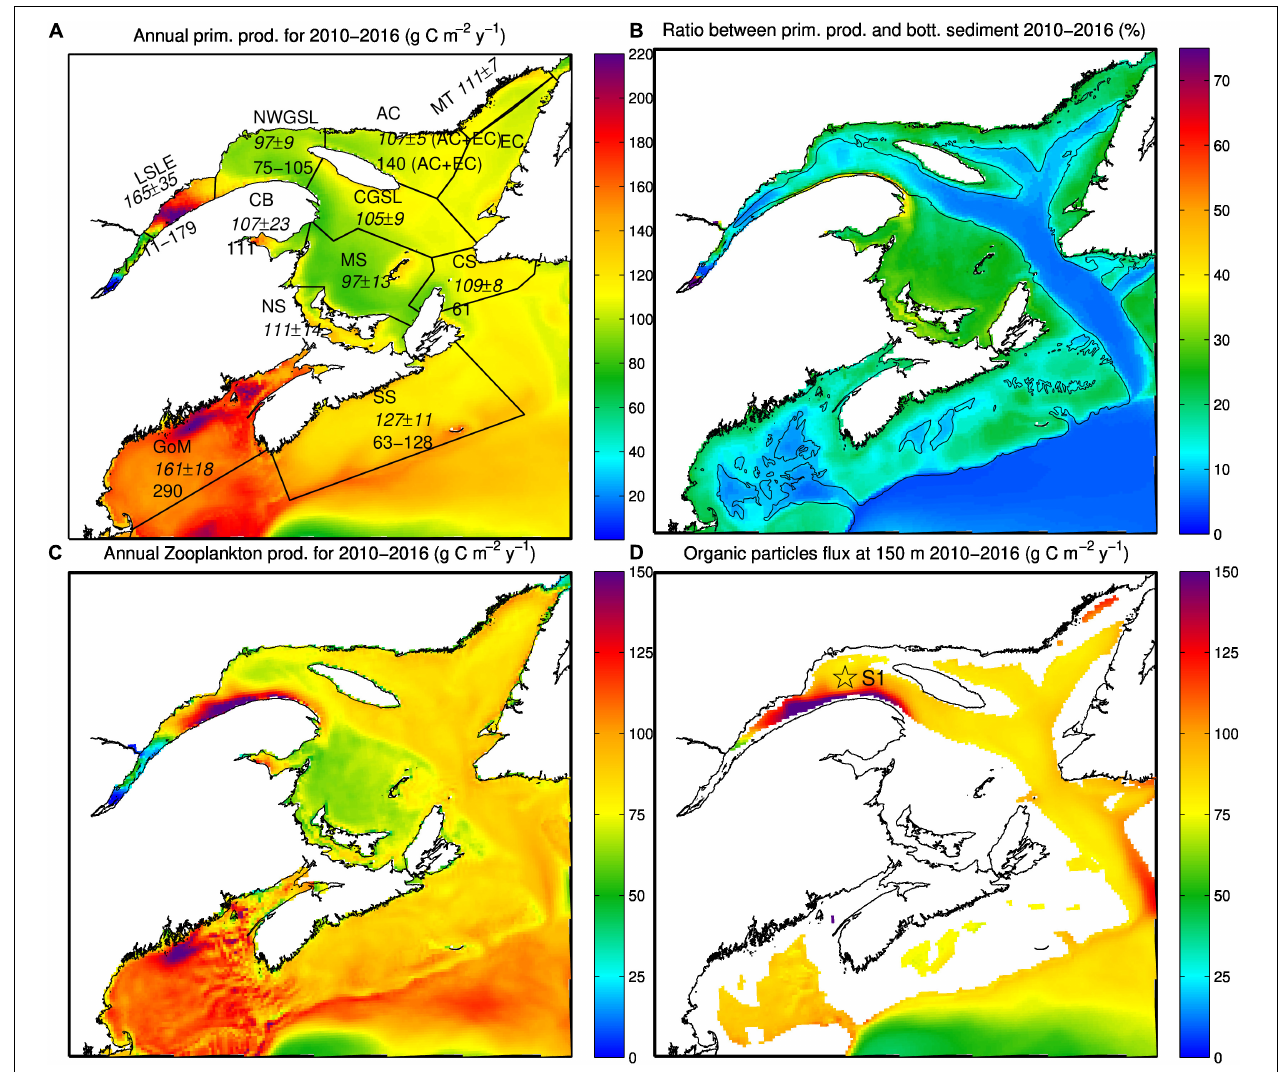
FIGURE 9 | Averages, over the 2010-2016 period, of (A) primary production (background color, g C m − 2 y − 1 ), (B) percentage of primary production that reaches the sediments, (C) zooplankton production (g C m − 2 y − 1 ), and (D) particulate organic matter flux across the 150-m horizon. The average primary production calculated by the model as well as its standard deviation is displayed in italic in panel (A) for different regions (LSLE, NWGSL, AC, EC, CGSL, CB, MS, CS, SS, and GoM). The range of estimates from the literature is also displayed below the simulated average when available. The estimates are taken from Sinclair et al. (1976); Levasseur et al. (1984), and Therriault and Levasseur (1985) in LSLE, Sévigny et al. (1979) and Savenkoff et al. (1996) in the NWGSL, in Savenkoff et al. (1996) for AC+EC and CS, in Legendre (1971) for CB, in O’Reilly and Busch (1984) for the GoM, in Fournier et al. (1977); Mills and Fournier (1979), Mousseau et al. (1996), and Shadwick et al. (2011) for the SS. The 200 m isobaths is displayed in (B) . Station S1 of Savenkoff et al. (1996) is displayed in panel (D)